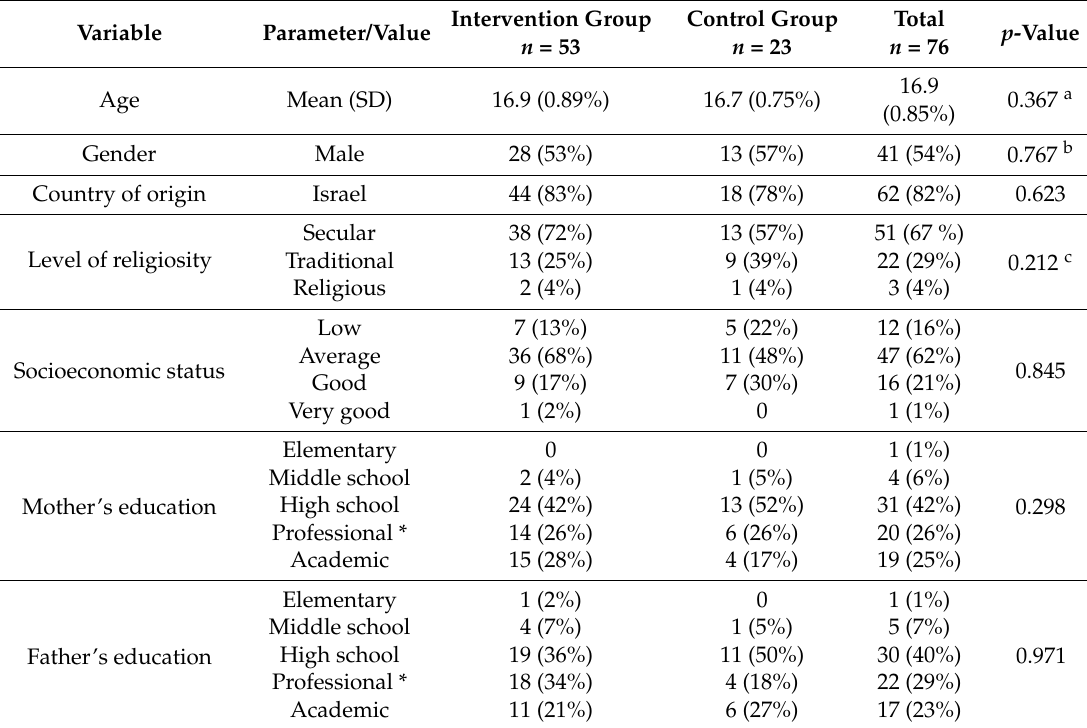
Table 1. Demographic background of study and control groups ( n = 76).